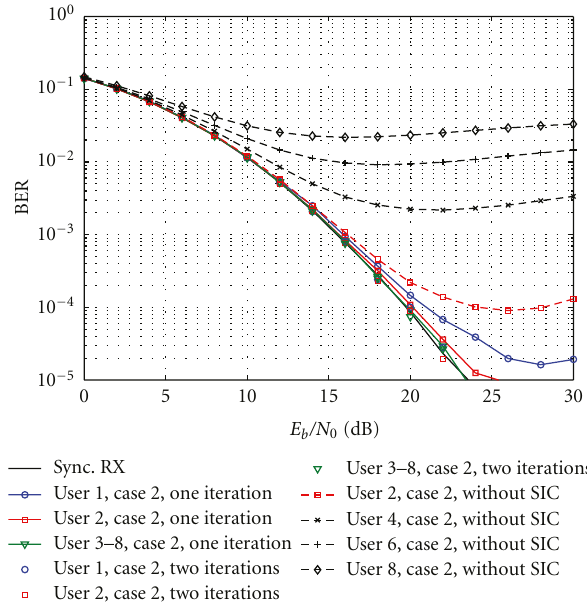
Figure 8: BER performance of each user, τ =